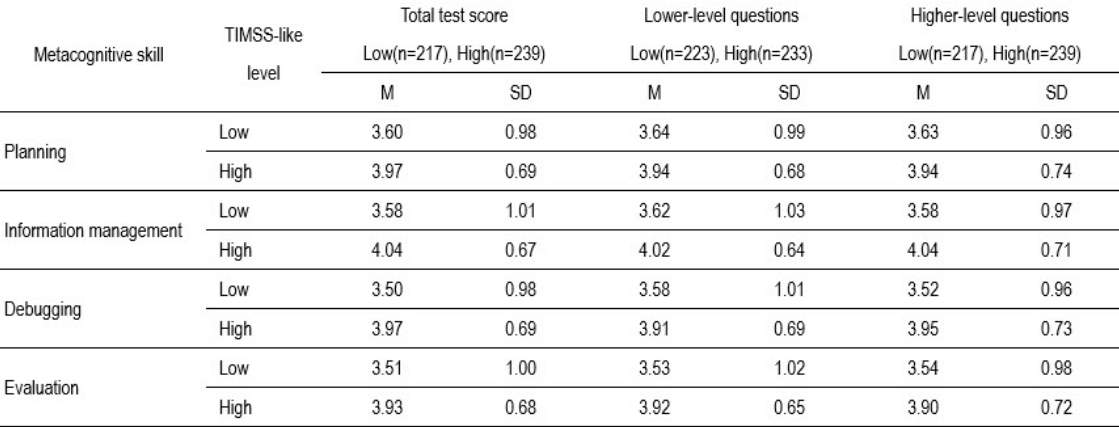
Means and standard deviations of metacognitive awareness perceptions for Grade